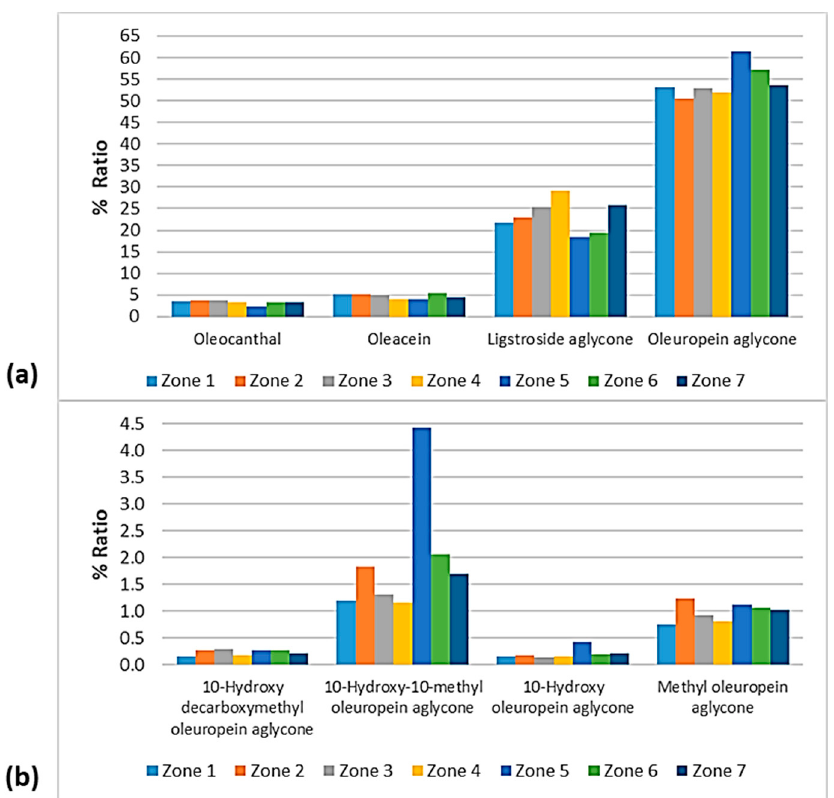
Figure 15. % Ratio of the secoiridoids ( a ) oleocanthal, oleacein, ligstroside aglycone, and oleuropein aglycone; and ( b ) methyl oleuropein aglycone, 10-hydroxy-10-methyl oleuropein aglycone, 10-hydroxy decarboxymethyl oleuropein aglycone, and 10-hydroxy oleuropein aglycone to the phenolic content in the EVOOs between the zones of Lesvos (Zones 1–7).